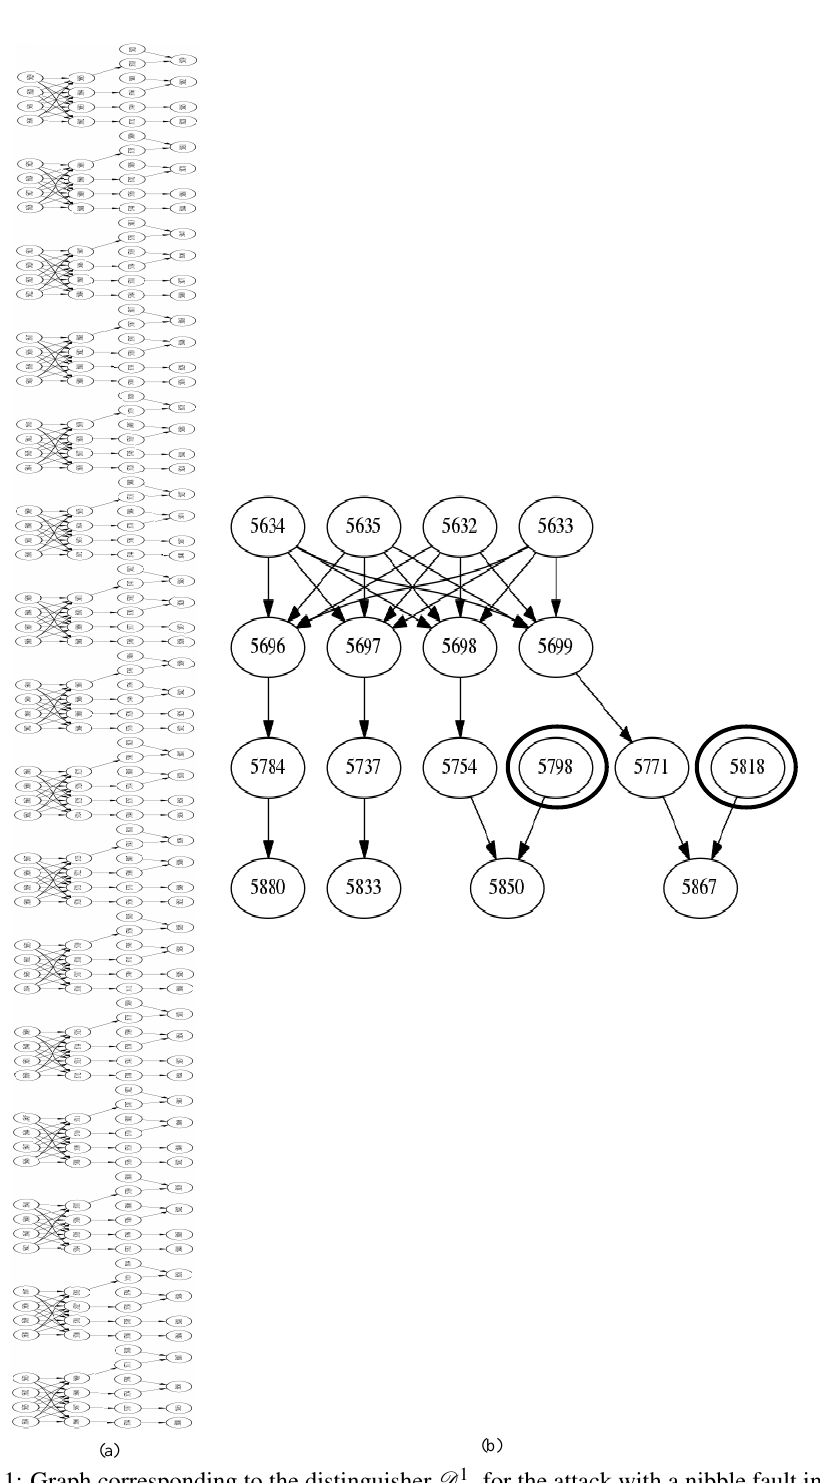
Figure 11: Graph corresponding to the distinguisher D 1 at the 25-th round on GIFT; (a) The complete graph from the tool (used to extract the keys of round 27), (b) One independent computation chunk/